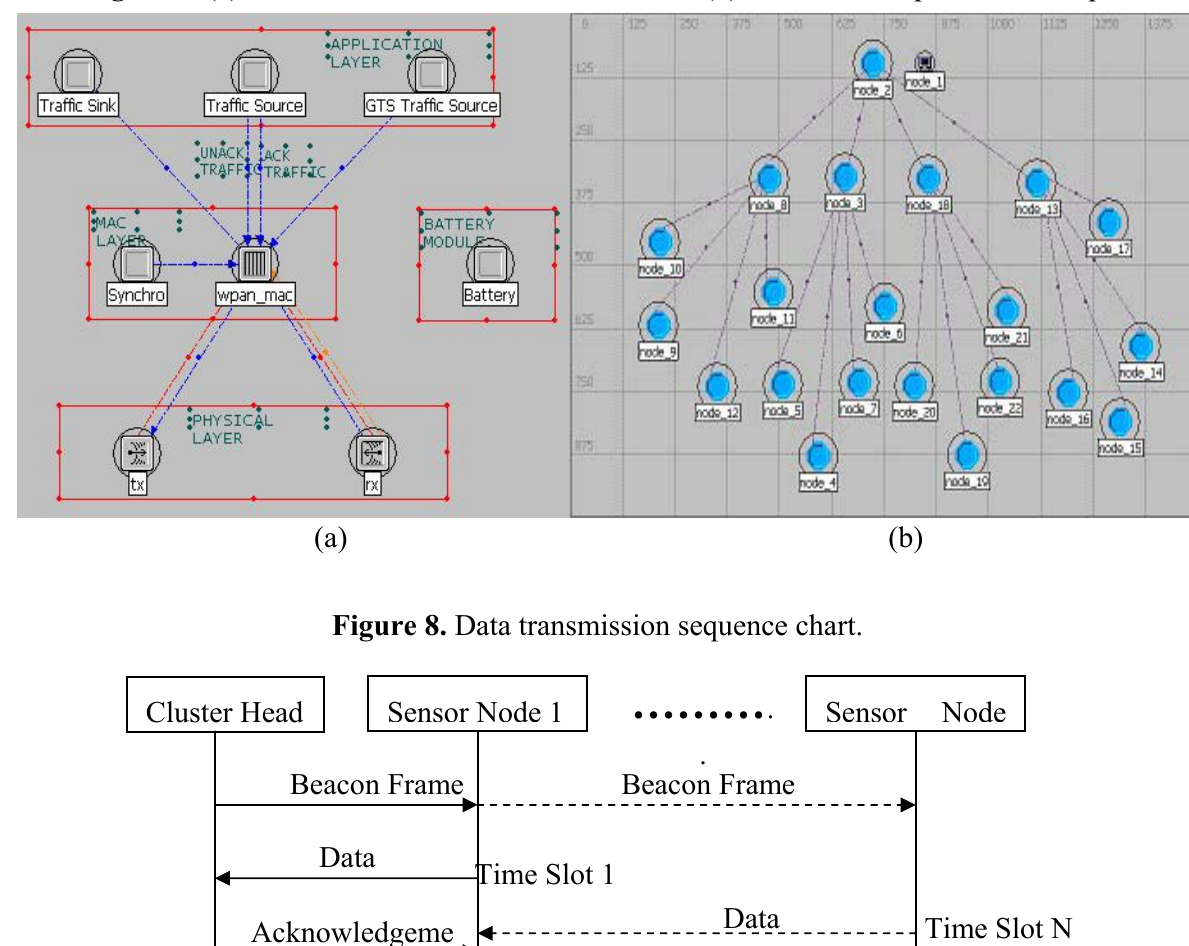
Figure 7. (a) The cluster-star network node model. (b) Simulation experiments setup.